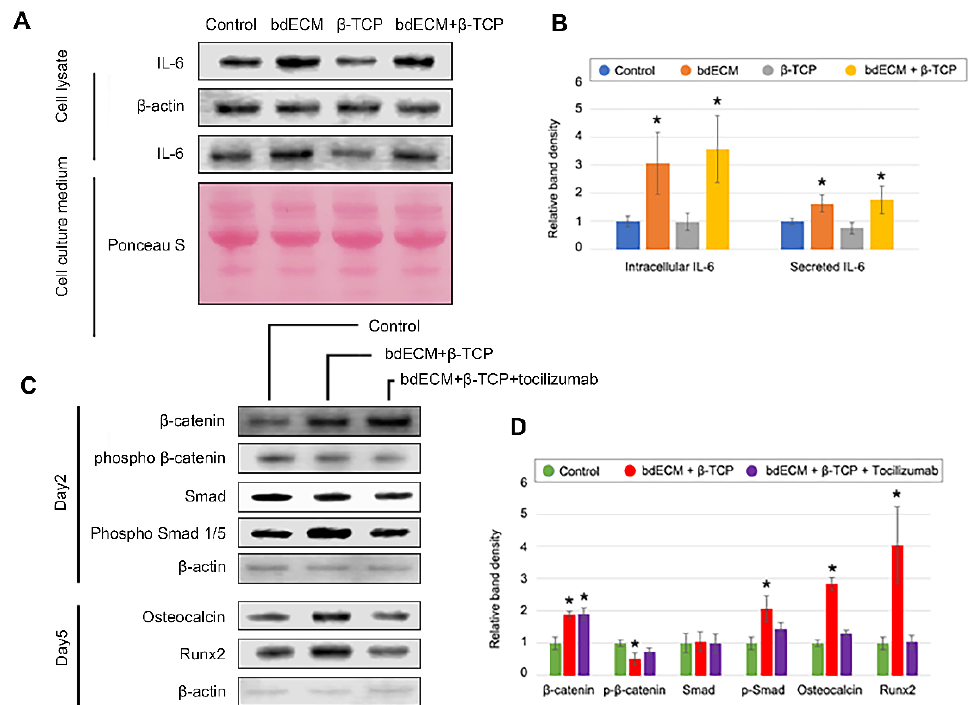
Figure 5. Loss of function study of IL-6. ( A , B ). Three different materials provided with pre-osteoblast MG63 cell lysate and cell culture medium-derived protein were blotted. The bdECM group and mixture group (bdECM and β -TCP) showed IL-6 overexpression compared to the control and β -TCP group both in cell lysate and cell culture medium; ( C , D ). The IL-6 antagonist tocilizumab-treated mixture group showed neutralization of the BMP2 signaling pathway and bone formation. In contrast, the canonical Wnt signaling pathway was not neutralized by tocilizumab. All data were expressed as mean ± standard deviation and asterisk indicates statistical significance ( p < 0.05) compared to control.